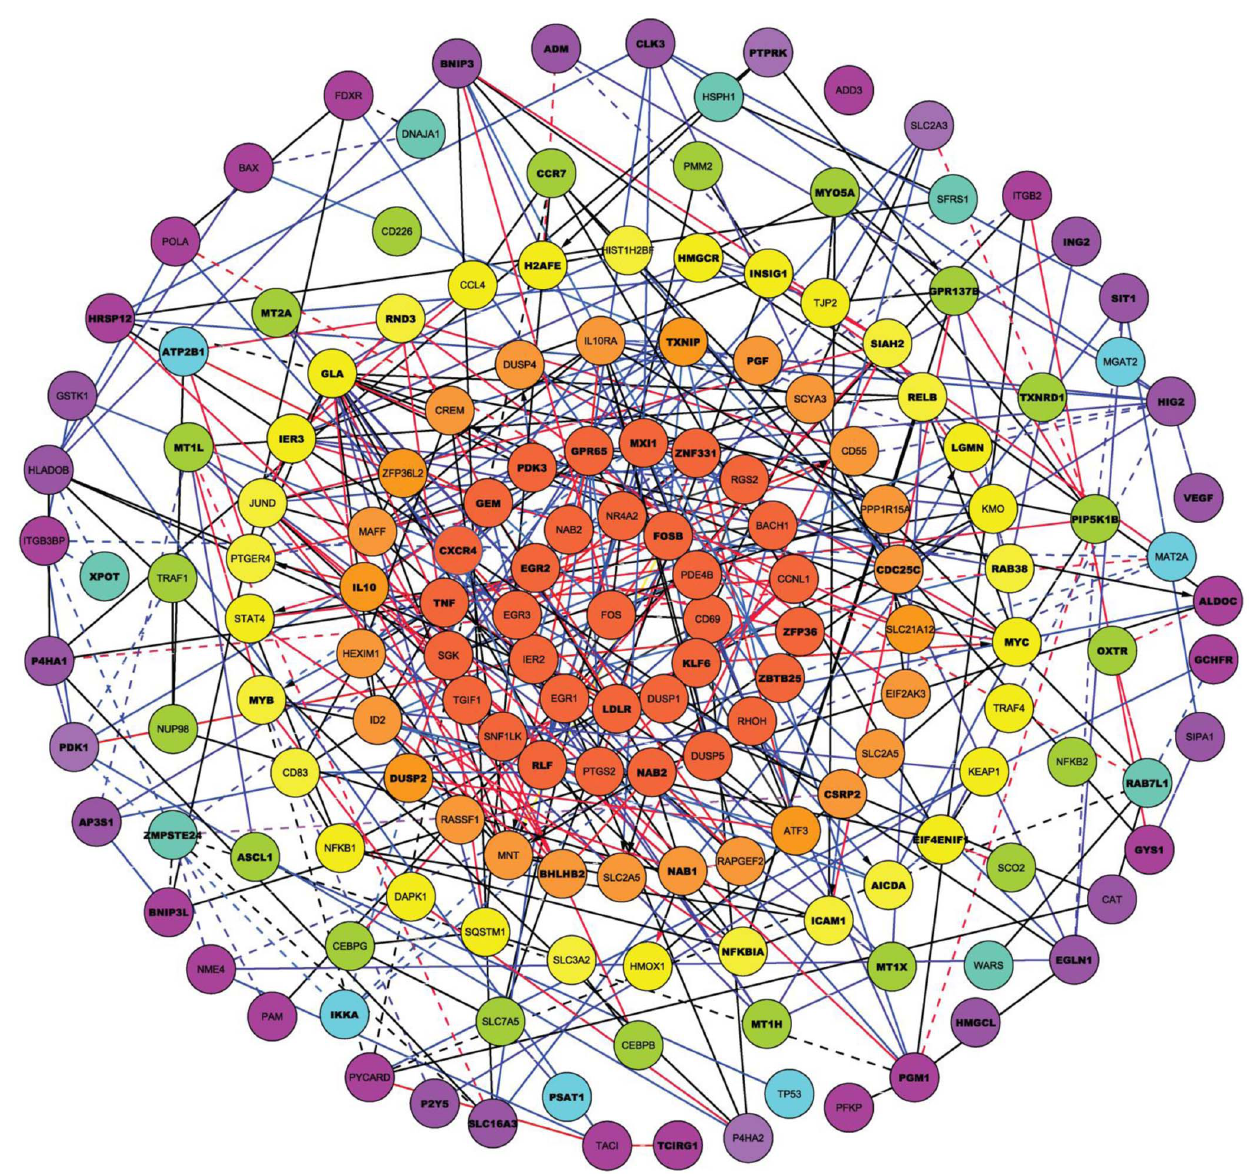
Figure 8. Gene network interaction after B cell stimulation of SLE patient and normal control samples. A gene network interaction map (from the initial analysis group) built using the partial correlations method is shown. Genes were grouped in different colored clusters representing maximum expression levels at various time points after B cell stimulation. The center gene clusters represent genes with maximum expression levels obtained after 0.5 hours of stimulation; then followed by colored circles for genes with maximum expression levels at 1, 2, 4, 8 hours, while the genes in peripheral circle reach maximum expression levels 16 to 24 hours after stimulation. Blue lines linking genes represent gene associations found in normal control samples. Red lines represent gene associations found in SLE patient samples. Black lines indicate gene associations found in both groups. Dashed lines represent negative gene associations. doi:10.1371/journal.pone.0071397.g008 profiles that are different between the two phenotypic groups were examined.